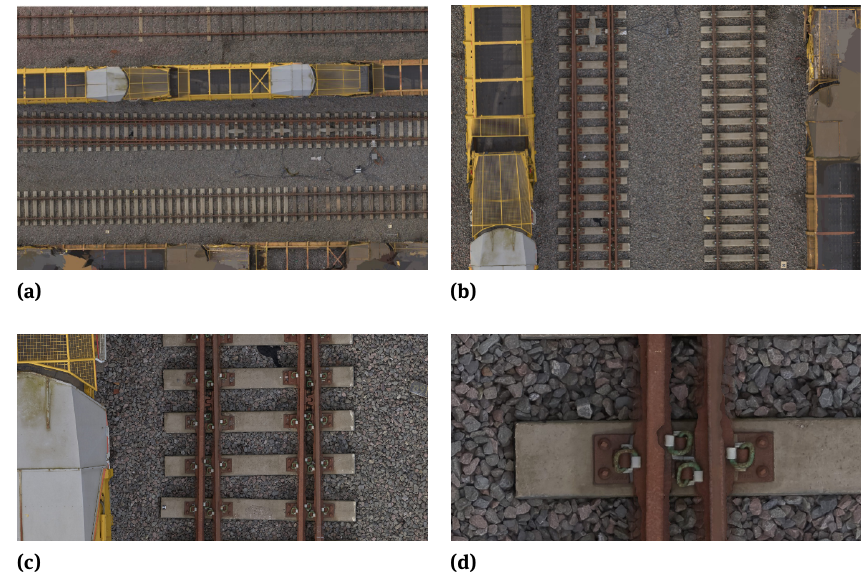
Figure 1: UAV visualization of the station track inspection: a) image of a track fragment with a turnout, b), c) and d) subsequent enlarge- ments of the image of this track fragment with split rail defects